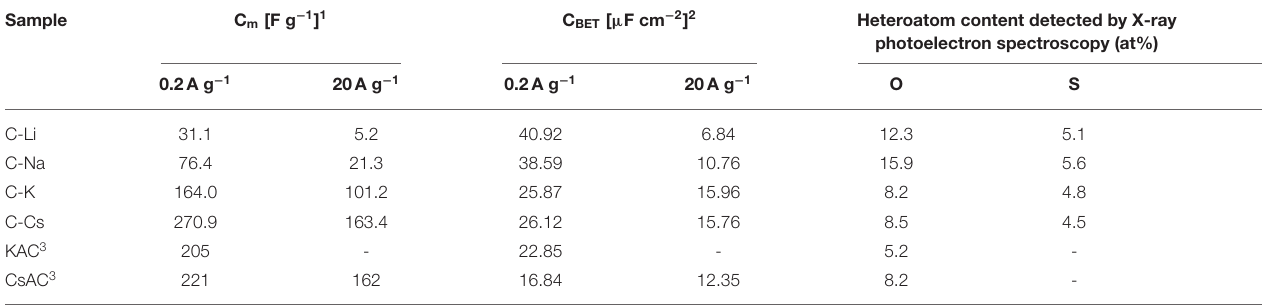
TABLE 3 | Specific capacitances at different current densities for metal ion activated carbons. Sample Heteroatom content detected by X-ray